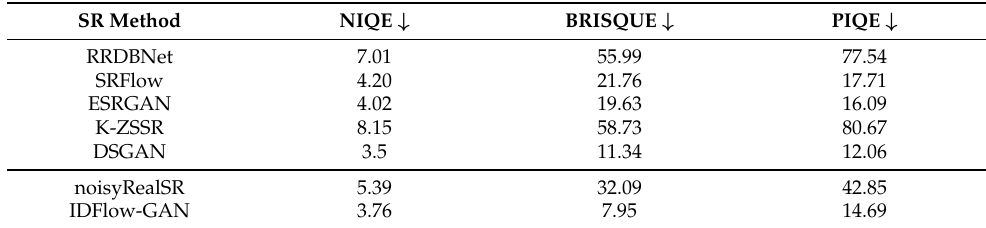
Table 4. Comparison with different state-of-the-art SR methods on the DPED-Test dataset with a scale of 4 × .